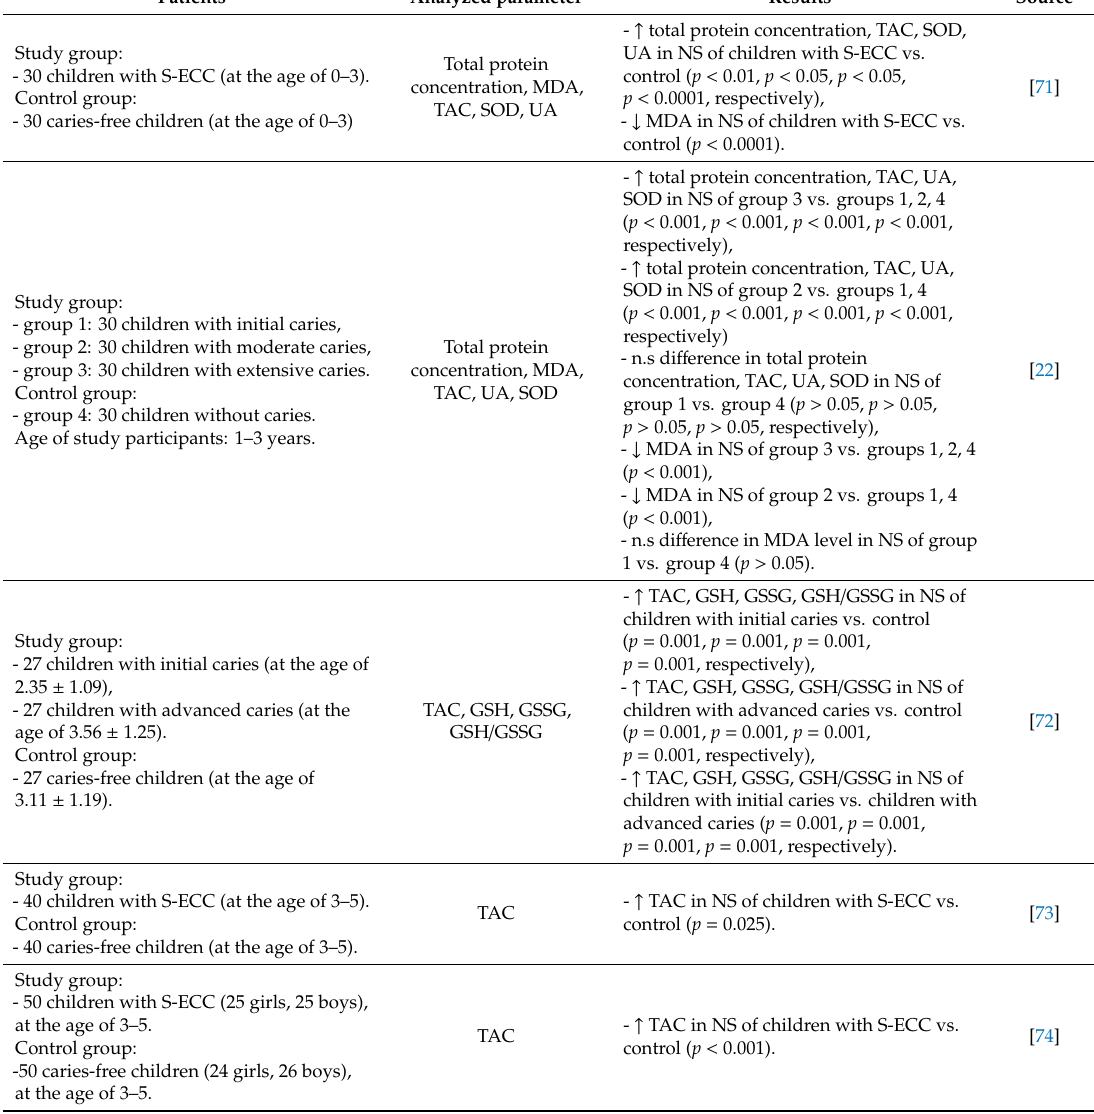
Table 1. Results of oxidative stress (OS) parameters in patients with caries. Patients Analyzed parameter Results